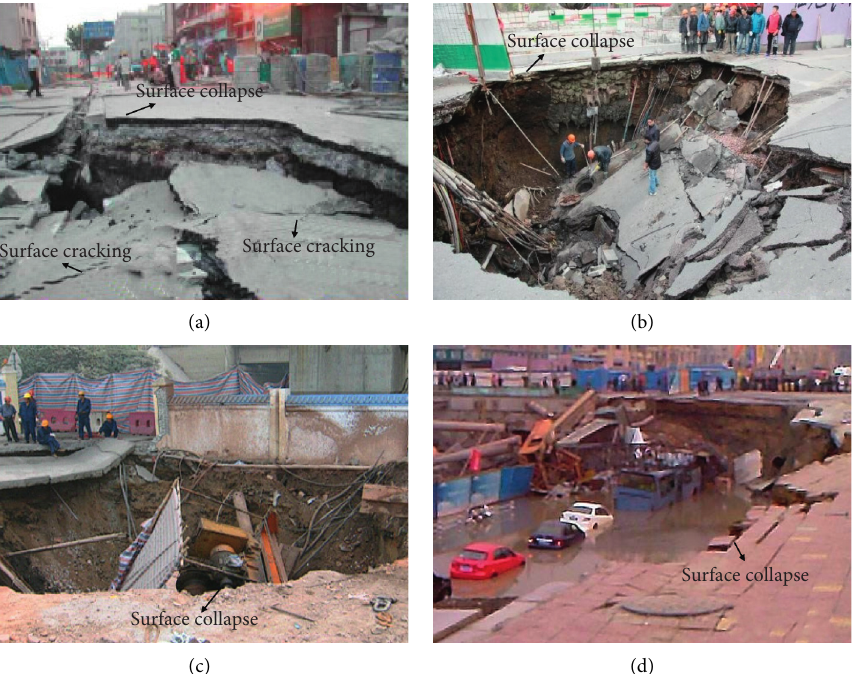
Figure 1: On-site photos of surface collapse and surface cracking. (a) Shanghai metro line 4, (b) Nanjing metro, (c) Guangzhou metro line 5, (d) Hangzhou metro line 1 [29].